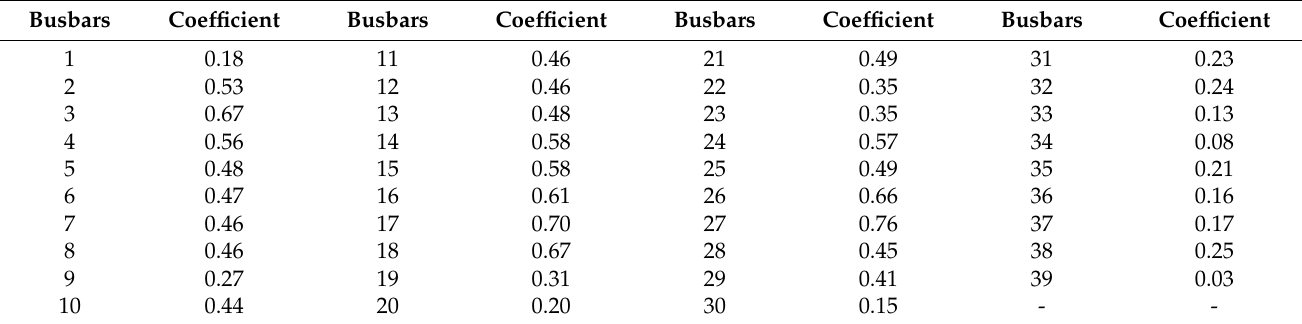
Table 1. The weighted coefficient of the exposed area for the IEEE 39 bus test system.